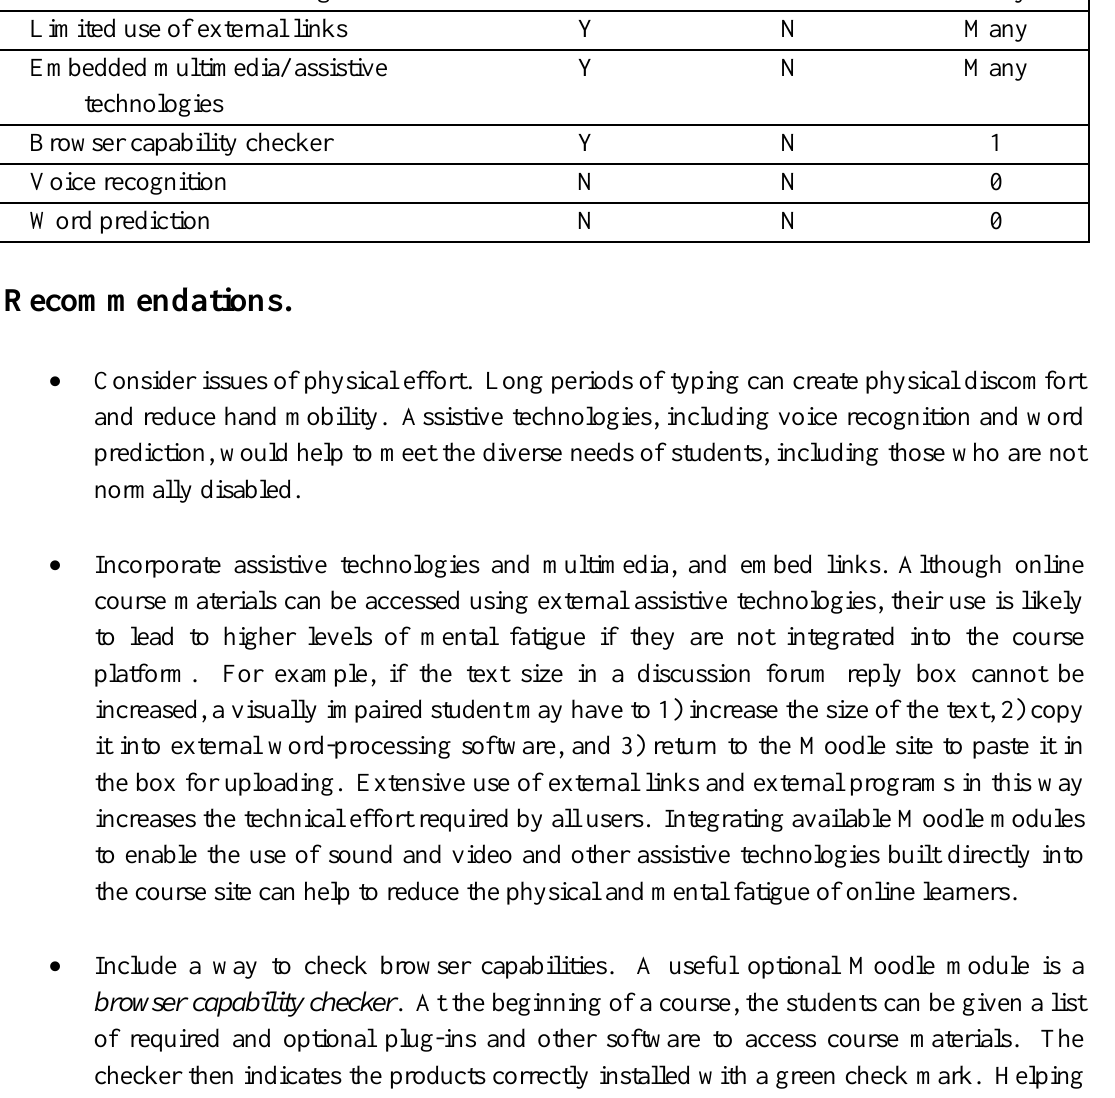
Availability of Moodle Modules Serving the Low Technical and Physical Effort Principle Low technical & physical effort Available in Built-in assistive technologies Y N Many Limited use of external links Y N Many Embedded multimedia/ assistive technologies